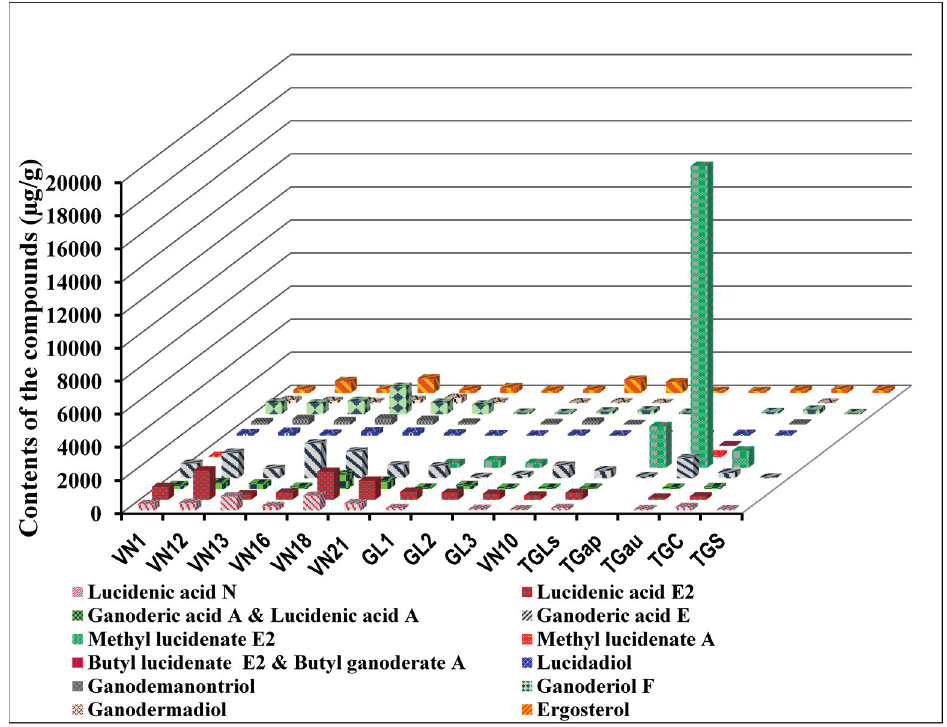
Figure 3. Content of 4 – 17 in various Linhzhi samples belong to groups A, B and